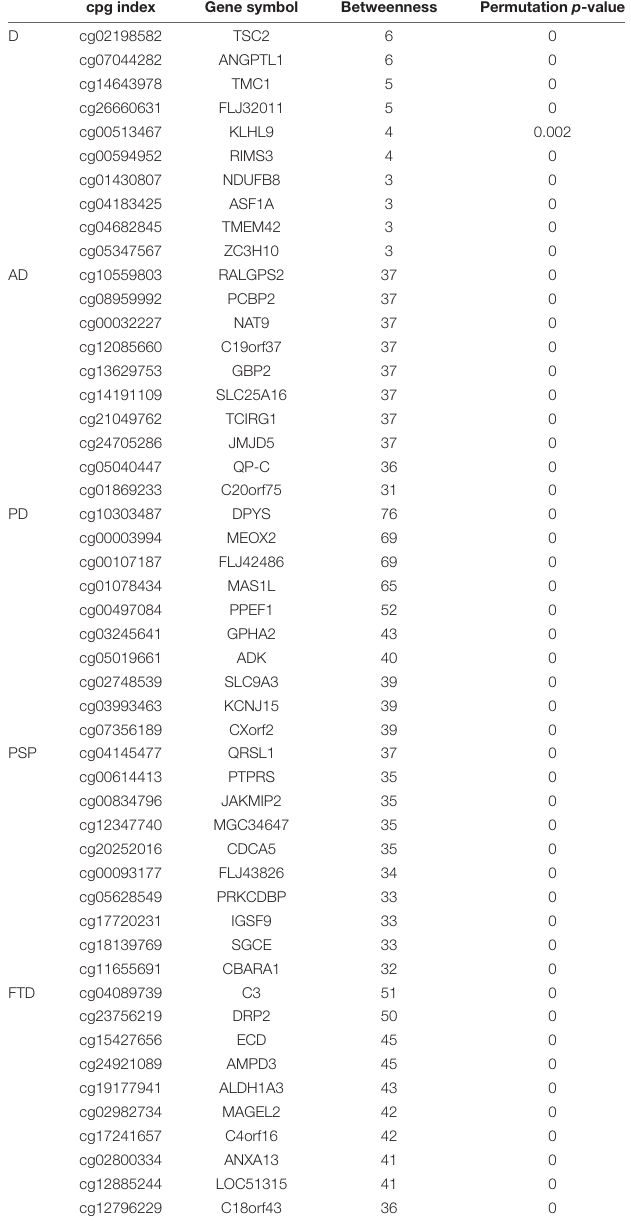
TABLE 6 | The top network markers. cpg index Gene symbol Betweenness Permutation p